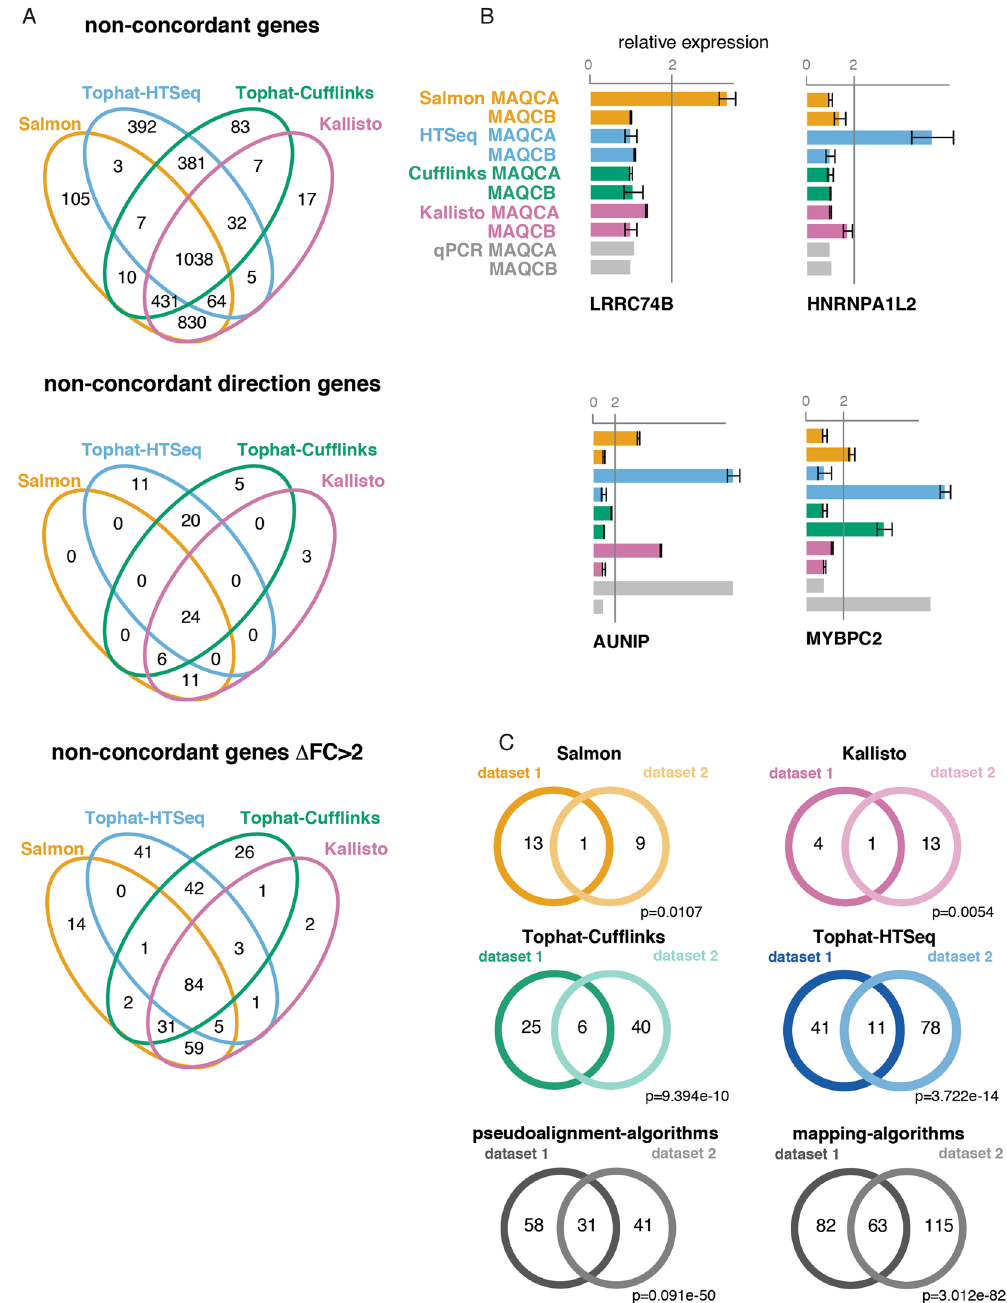
Figure 5. Each workflow (or workflow group) has specific non-concordant genes, which are reproducible identified in independent datasets. ( A ) Venn diagrams showing the overlap between the non-concordant genes with ∆ FC < 2, non-concordant genes with ∆ FC > 2 and non-concordant genes with opposite direction. ( B ) Examples of workflow-specific non-concordant genes. ( C ) Overlap of the non concordant genes with a ∆ FC > 2 between two independent datasets. The p-values (Fisher Exact test) represent the significance of the